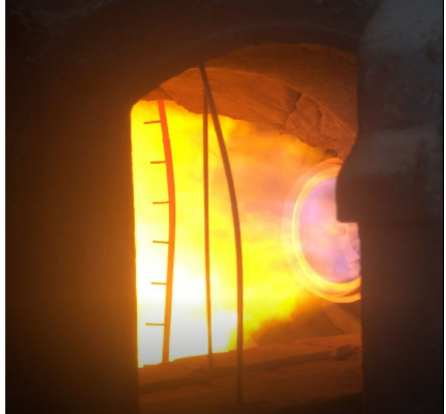
Figure 3. The flame of the burner in the furnace during the